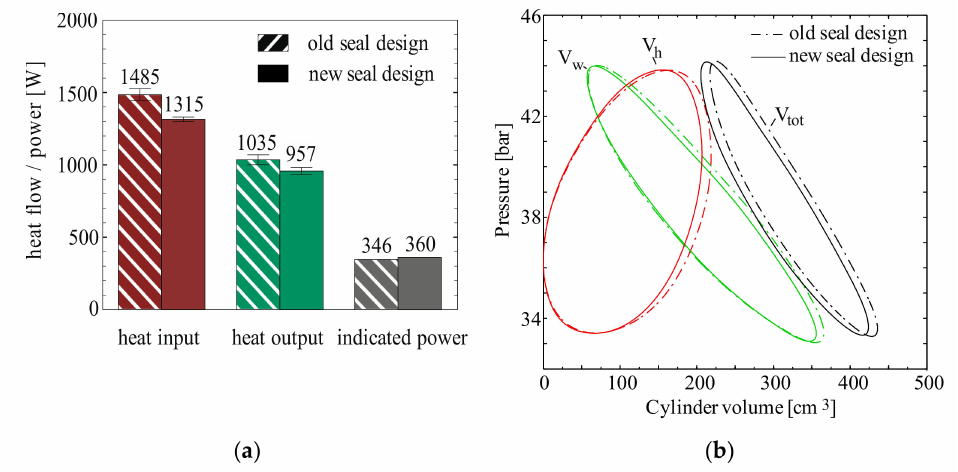
Figure 5. Experimental heat input, heat output and indicated power: ( a ) and p,V-plots ( b ) in Stirling mode with new and old seal design at nominal